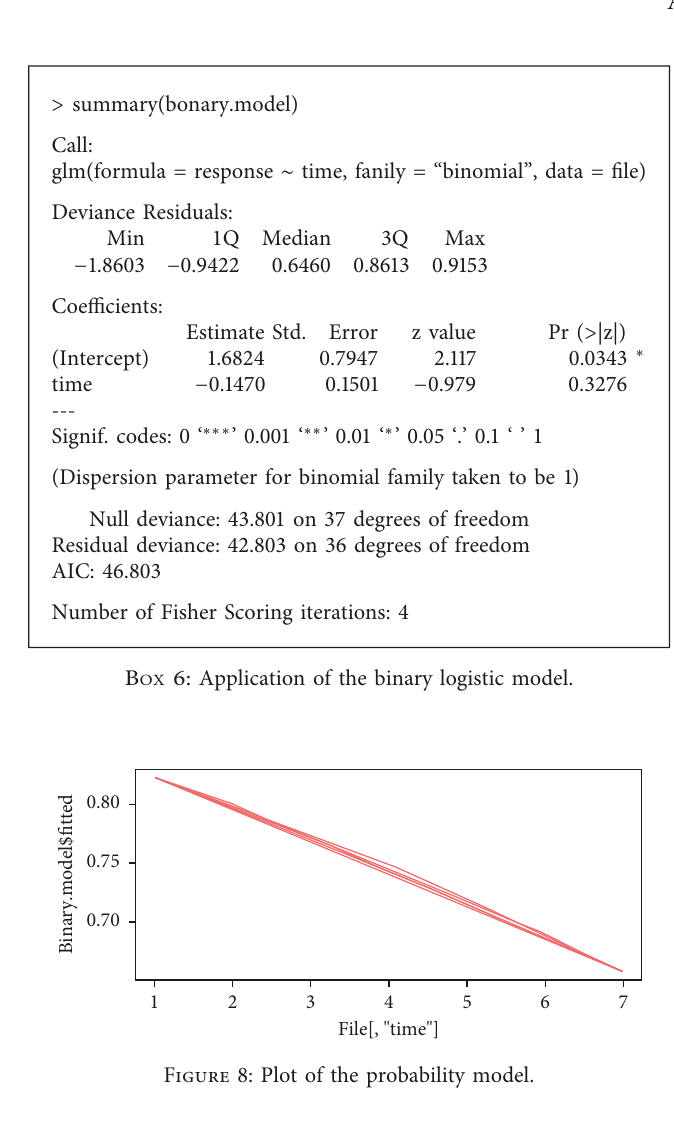
Figure 9: Comments on Q10: 13